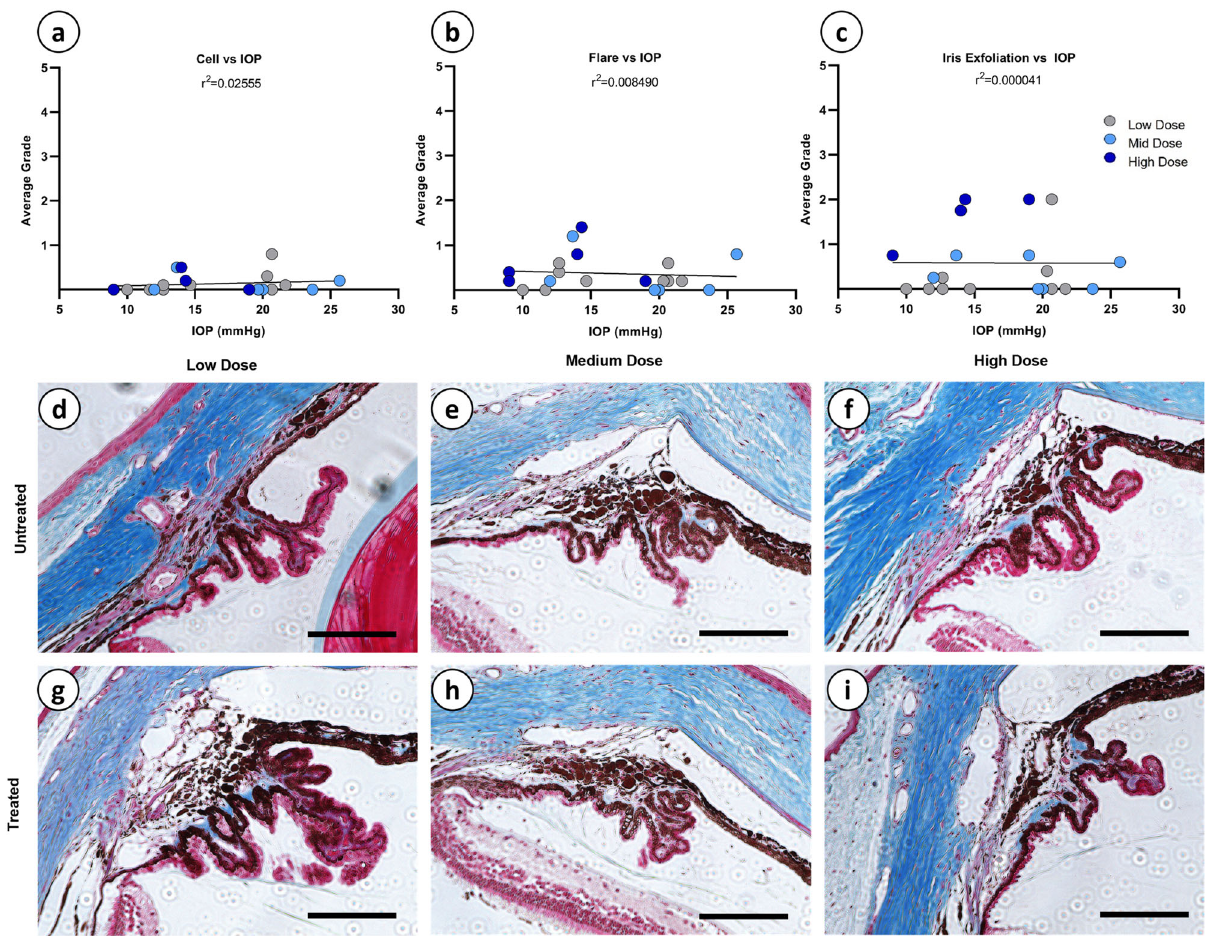
Fig. 8 Linear regression of in fl ammatory responses vs IOP and Masson trichrome staining of the ciliary body. Linear regressions correlating IOP to cell, fl are, and iris exfoliation ( a – c ) show no correlation between IOP reduction and the observed in fl ammation within the anterior chamber. Masson trichrome staining indicating collagen-based fi brosis (blue dye) was qualitatively analyzed in untreated ( d – f ) and contralateral treated eyes ( g – i ) (Magni fi cation = 20×, scale bar = 150 µ m), revealing no obvious differences between treated and untreated eyes at any